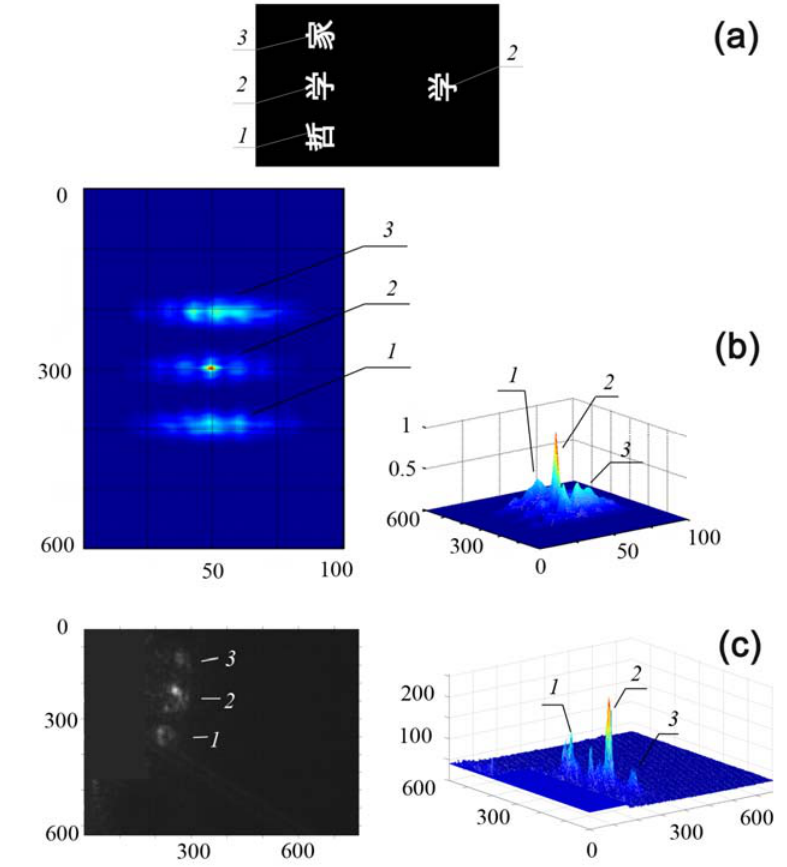
Figure 26. Recognition of hieroglyph 2 in a group of objects: ( a ) information pattern; ( b ) two-dimensional (left) and three-dimensional (right) images of calculated correlation field (signal coordinates are measured in pixels, signal intensities are measured in arbitrary units); ( c ) two-dimensional (left) and three-dimensional (right) experimental signal intensity distribution in the JTC output plane (signal coordinates are measured in pixels, signal intensities are measured in units of